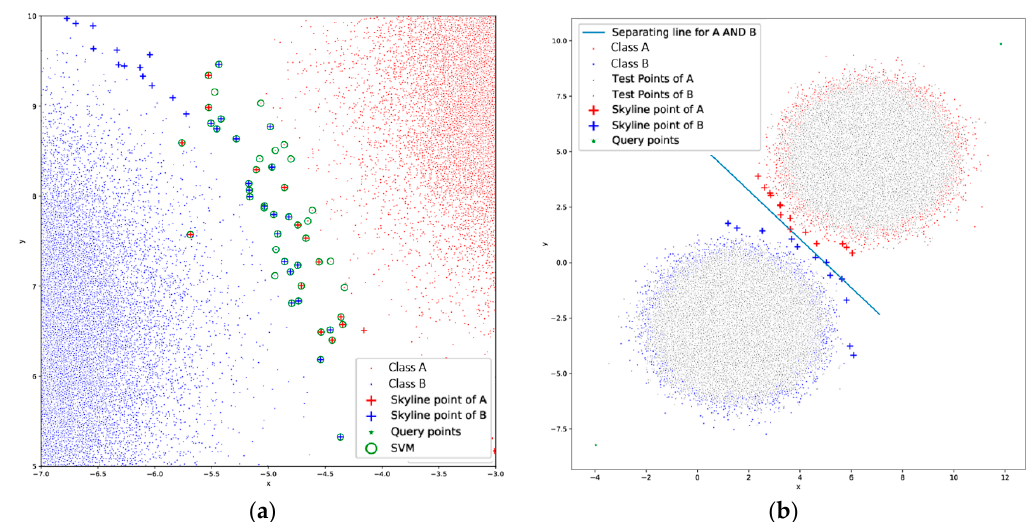
Figure 7. Polynomial curve-fitting approach.